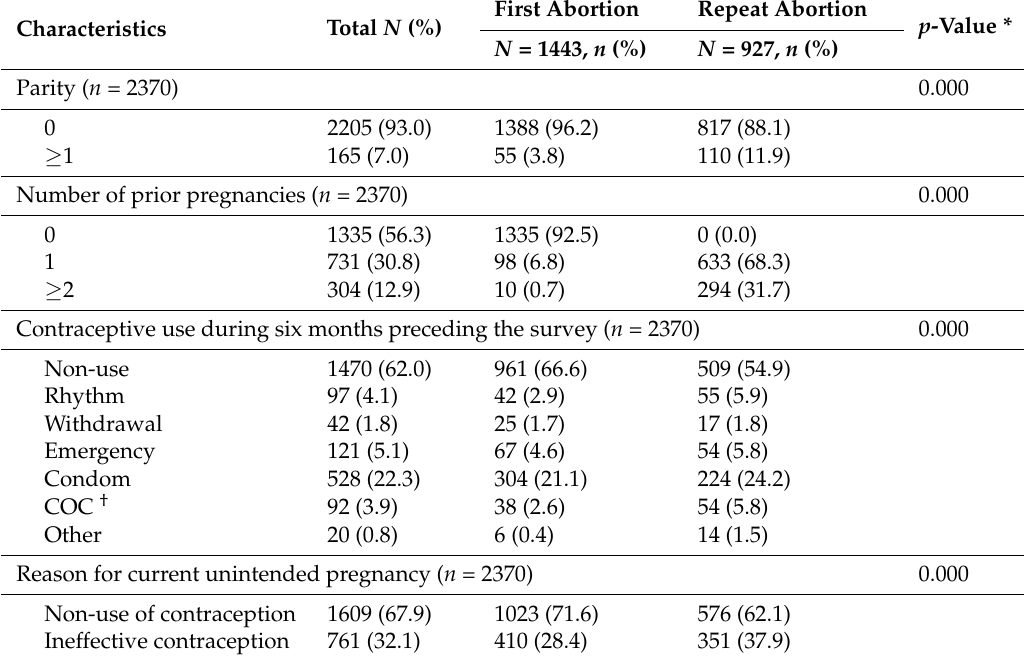
Table 2. Reproductive history, contraceptive use in six months before survey, and reason for current unintended pregnancy of adolescents receiving abortions by history of